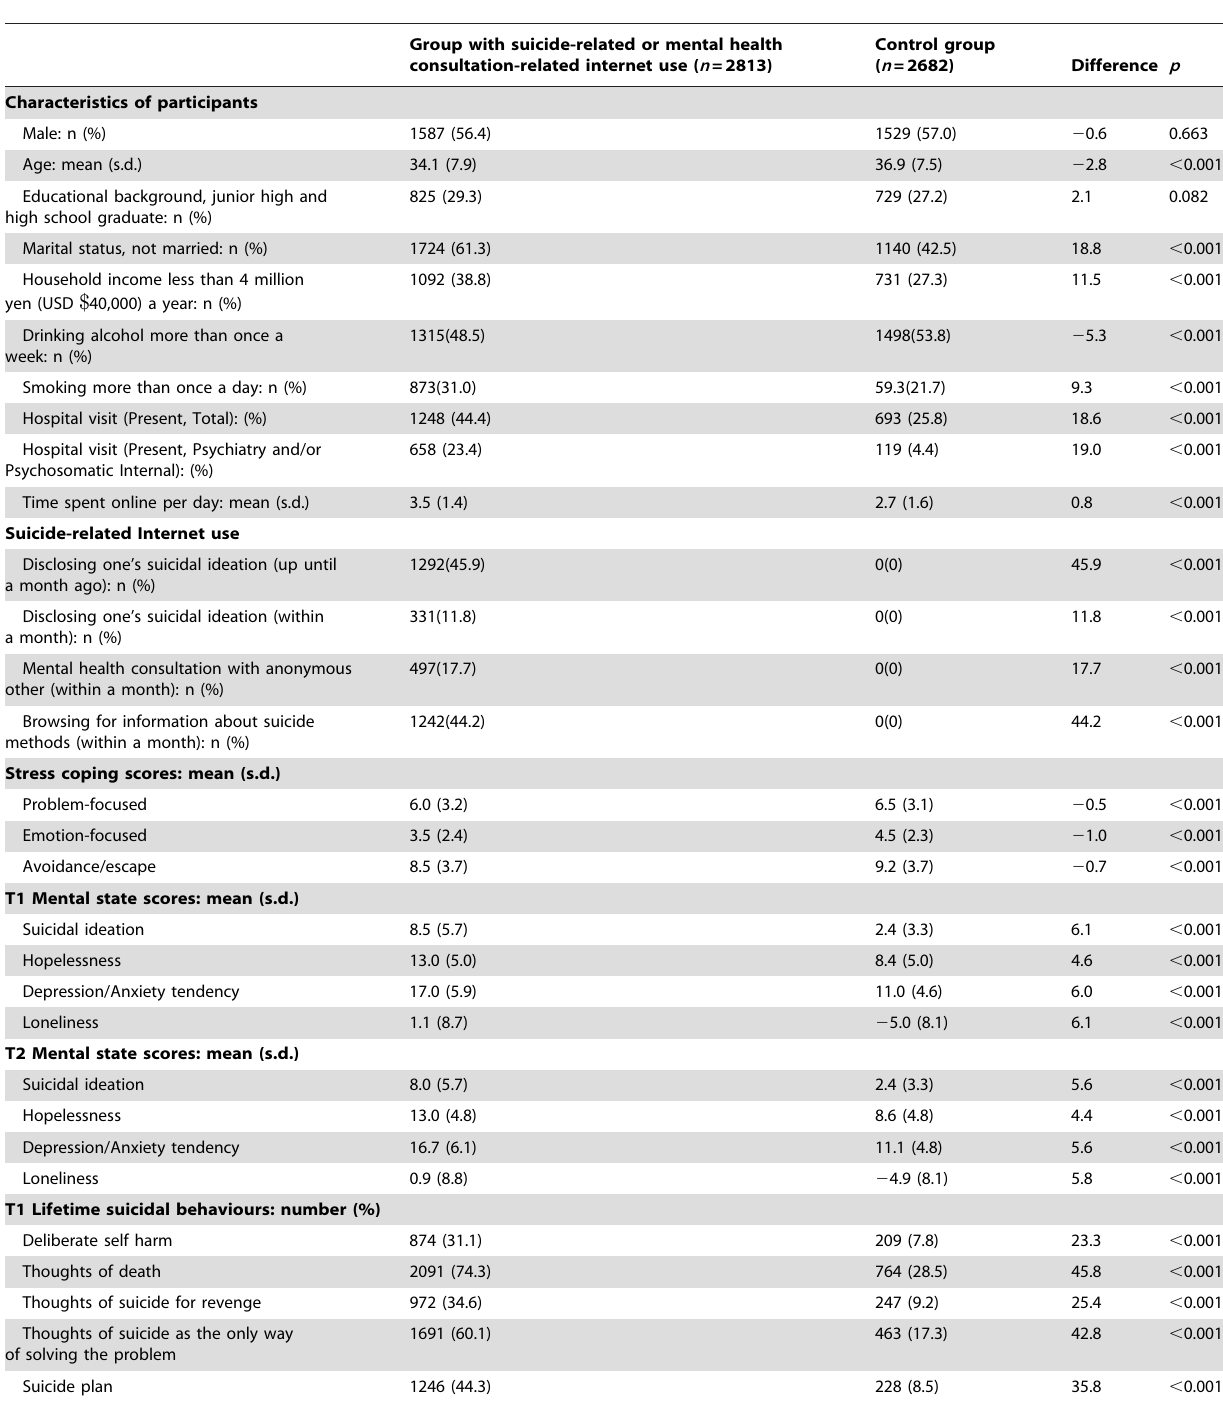
Table 2. Comparison between the group with suicide-related or mental health consultation-related internet use and the control group who completed T2